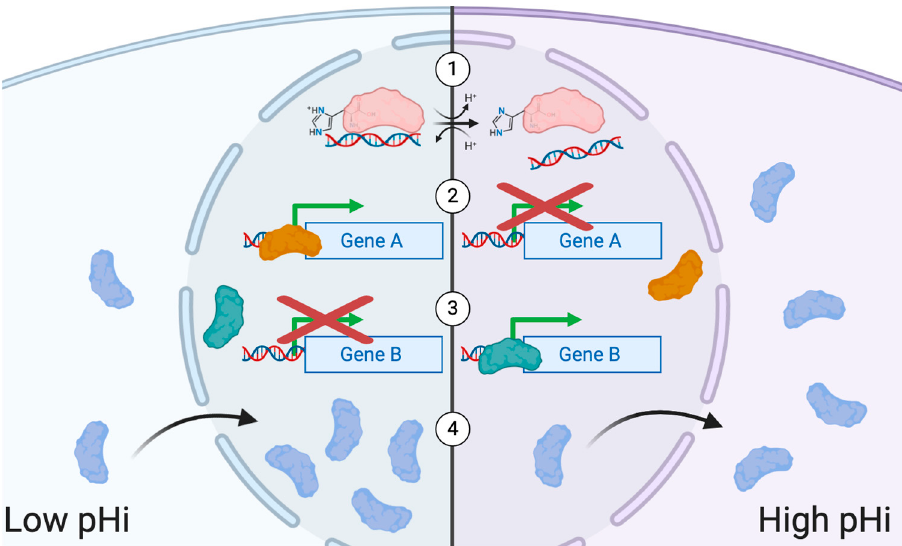
Figure 3. Roles for pHi dynamics in regulating transcription. ( 1 ) The protonation states of charge-bearing residues can affect the ability of transcription factors to bind DNA under different intracellular pH conditions. ( 2 ) Transcription factors that actively promote transcription of certain genes at low pHi can lose their ability to promote gene expression at high pHi. ( 3 ) Conversely, transcription factors that do not promote the transcription of certain genes at low pHi may gain the ability to promote gene expression at high pHi. ( 4 ) Proteins may exhibit pH-dependent subcellular localization. In the case of transcription factors, moving from the cytoplasm to the nucleus (or vice versa) depending on pHi.